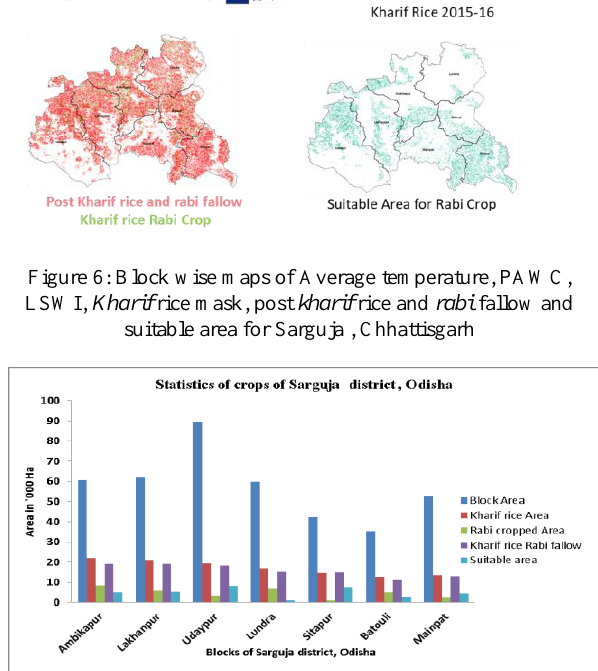
Figure 5. Block wise statistics in Sarguja district, Chhattisgarh 4.3 Site suitability analysis for Mayurbhanj (Odisha) Mayurbhanj district consists of 26 tehsils and 26 blocks.